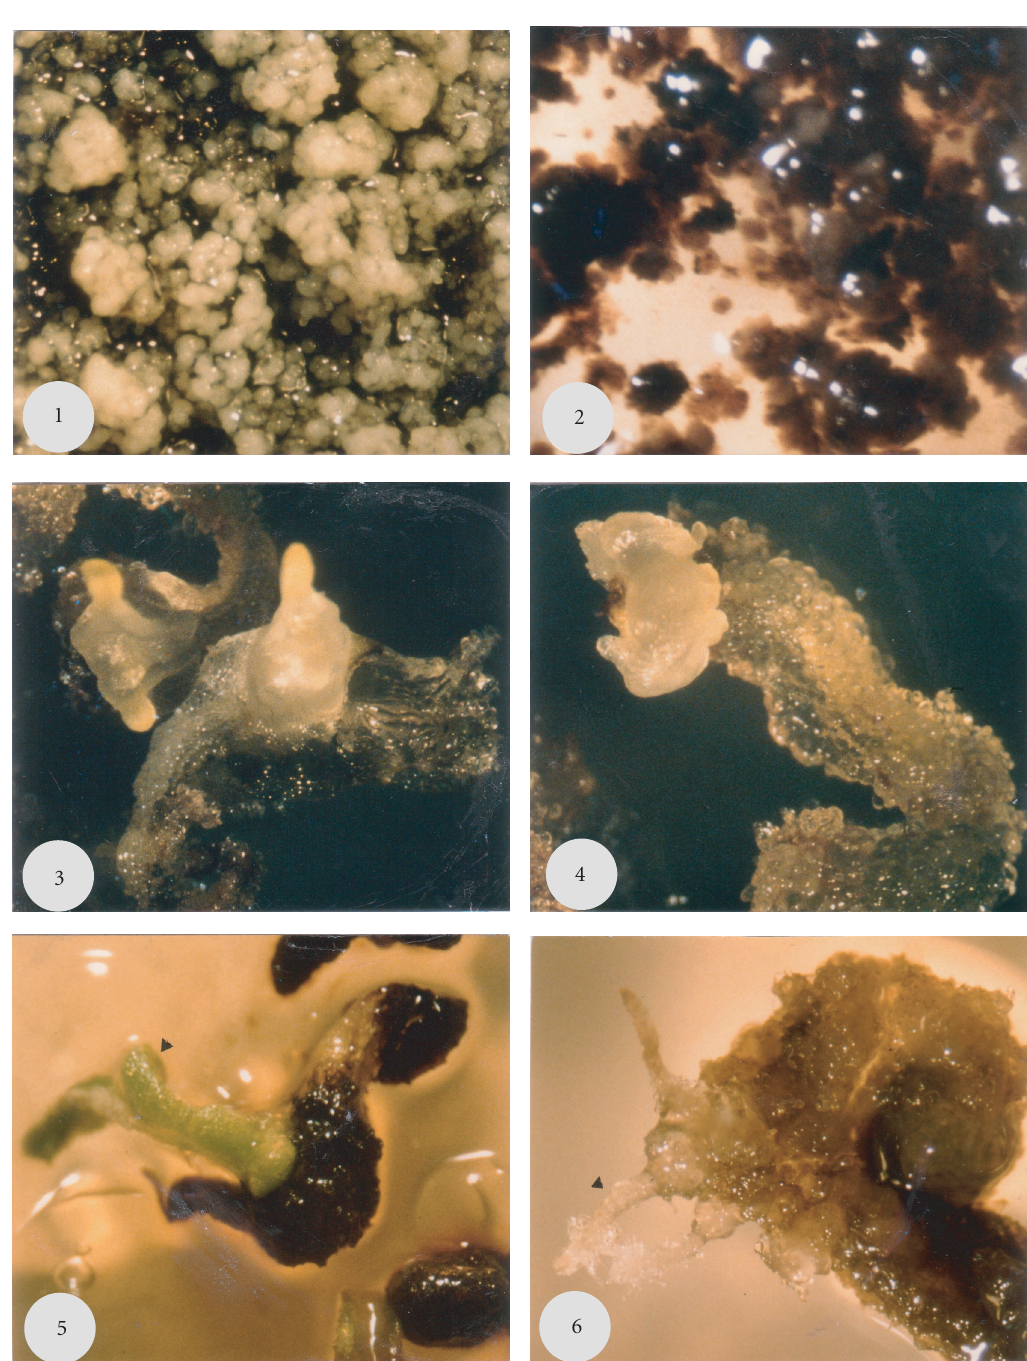
Figure 2: Somatic embryos of Papaver somniferum album . (1) Somatic proembryo and embryo in globular stage after transfer to solid medium LS-NAA/BA-S60 ( NAA/BA = 0 . 2 / 0 . 1 mg/l ) ( × 10 ) , (2) Nonembryogenous suspensions after transfer to solid medium LS-S30 ( × 10 ), (3) Two somatic embryos of 20days old, from cotyledon, on solid medium LS-NAA/kinetin = 0 . 2 / 0 . 1 mg/l ( × 10 ) , (4) Proembryo of 20days old,from cotyledon,on solid medium LS-NAA/kinetin = 0 . 2 / 0 . 1 mg/l ( × 10 ) ,(5) Plant of 5weeks from a cotyledon on solid medium LS-NAA/kinetine = 0 . 2 / 0 . 1 mg/l ( × 10 ) ,(6) Rhizogenous callus from a cotyledon on solid medium LS-NAA/kinetine = 0 . 2 / 0 . 1 mg/l ( × 10 ) . Scale: 1 cm = 1